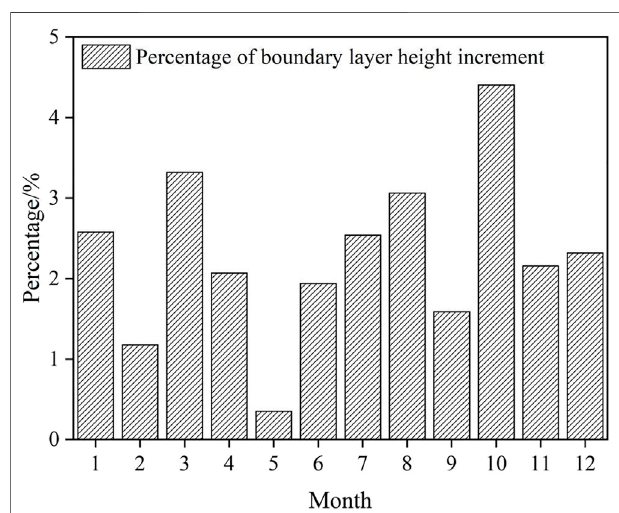
FIGURE 7 | Percentage of simulated planetary boundary layer height increment caused by emission reduction from 2015 to 2021.